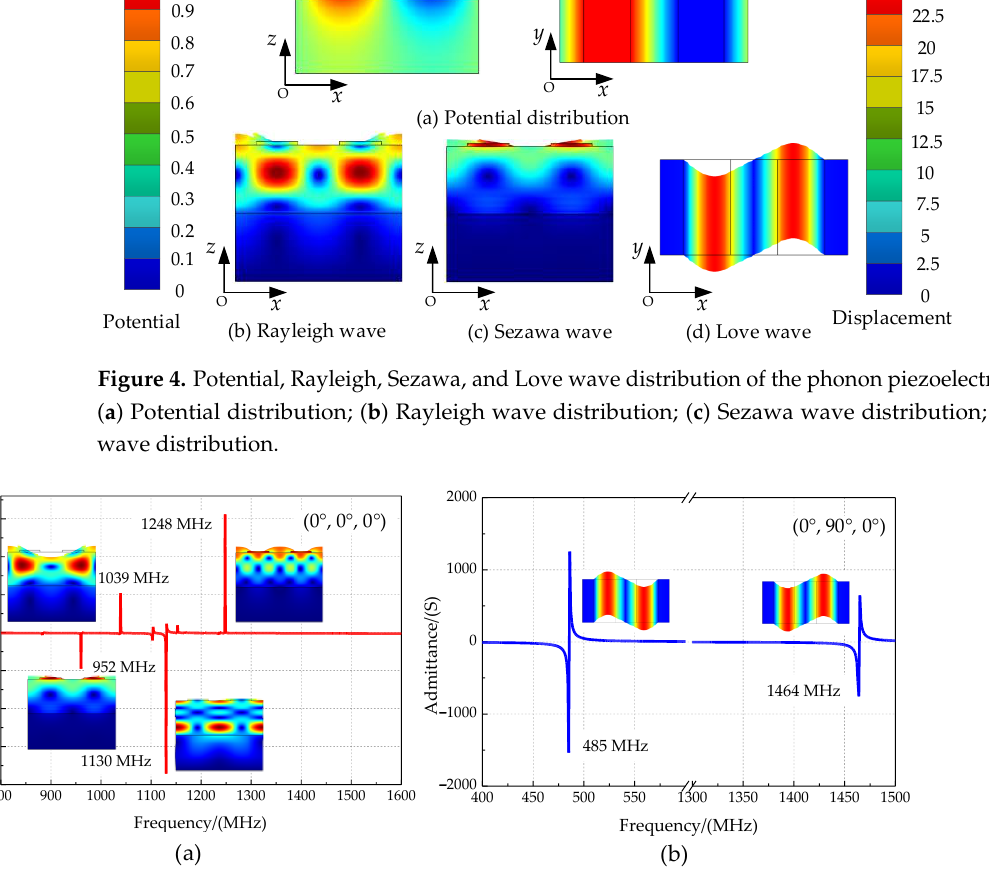
Figure 5. Admittance characteristics for different crystalline phonon device structural units. ( a ) (0°, 0°, 0°) ZnO; ( b ) (0°, 90°, 0°) ZnO.